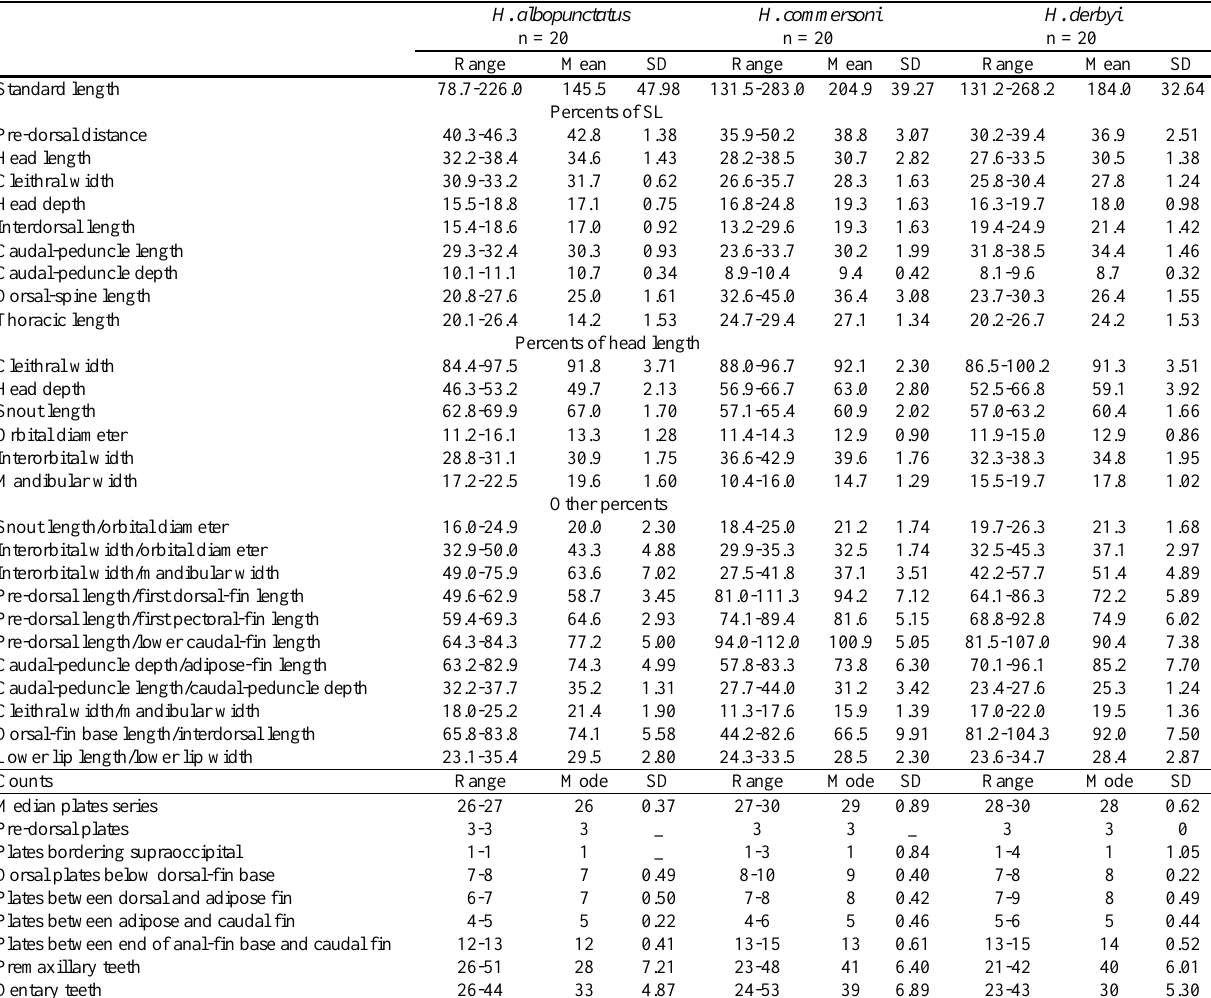
Table 1. Morphometric data and counts of Hypostomus albopunctatus , H. commersoni and H. derbyi from the rio Iguaçu basin, Brazil. SD = standard